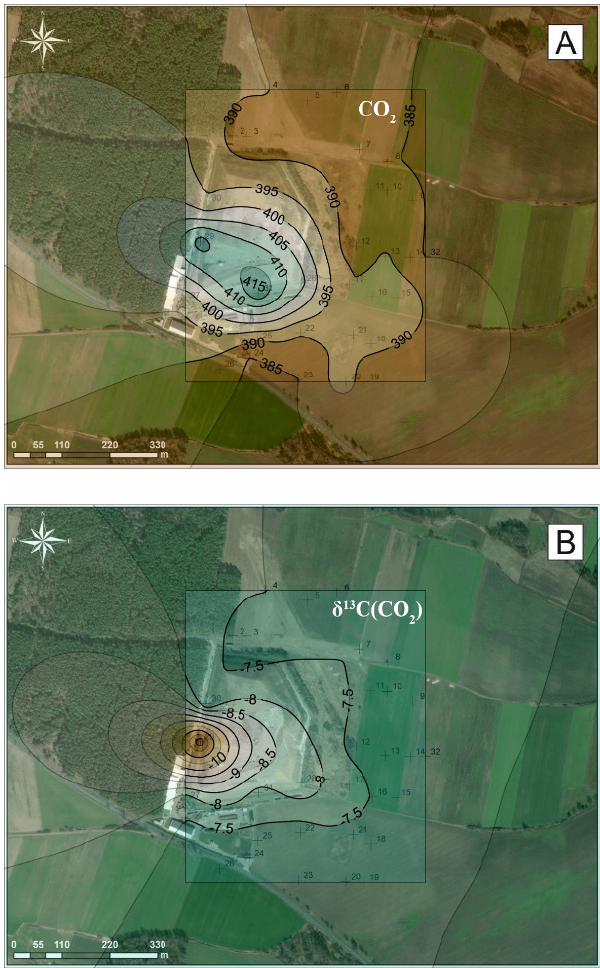
Figure 4. Spatial distribution of CO 2 mole fraction ( A ) and the δ 13 C(CO 2 ) values ( B ) in the vicinity of the municipal waste landfill sampled on 22 August 2017 campaign. Brightness rectangle covered sampling points, whereas the area outside has been extrapolated.